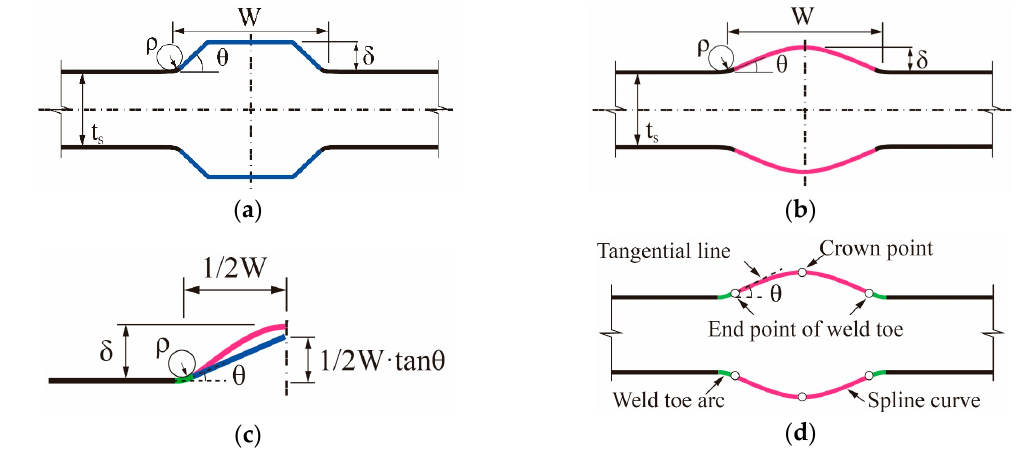
Figure 1. Geometric model of a butt-welded joint: ( a ) trapezoid model; ( b ) spline curve model; ( c ) implicit constraint of trapezoid model; and a ( d ) three-feature point spline curve model.